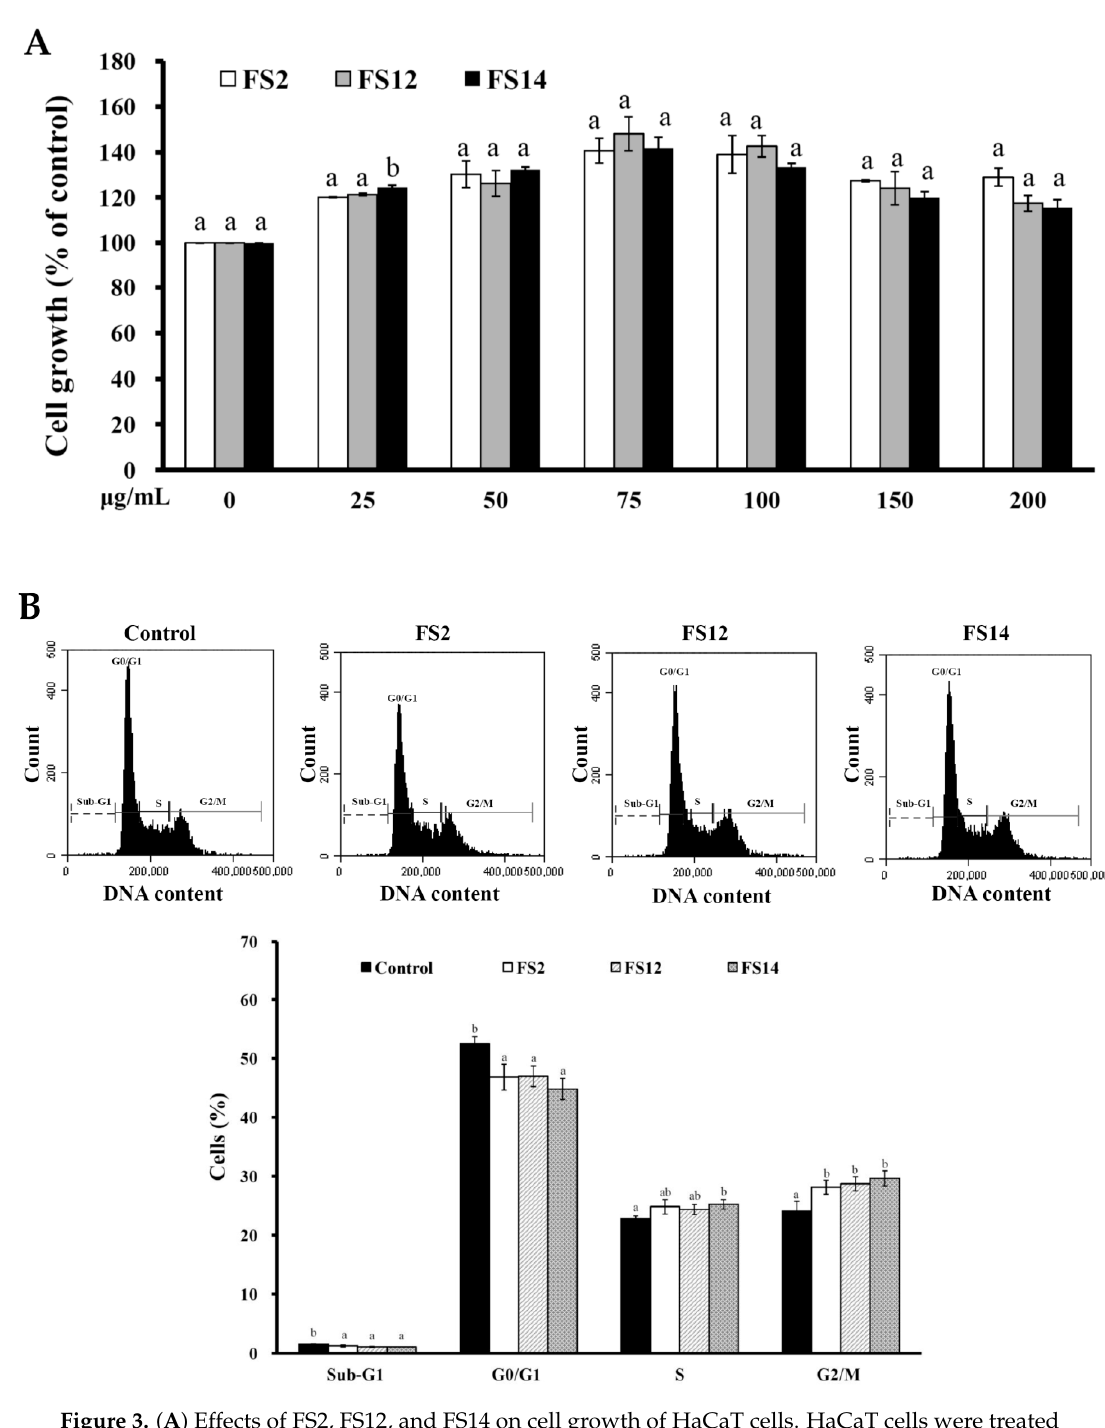
Figure 3. ( A ) Effects of FS2, FS12, and FS14 on cell growth of HaCaT cells. HaCaT cells were treated with different concentrations of FS2, FS12, or FS14, and the cell growth was measured by the MTT assay. The bar graph represents the three experiments and shows the percentage of cell growth for FS2, FS12, and FS14 at different concentrations. ( B ) Effects of FS2, FS12, and FS14 on cell cycle profiles of HaCaT cells. HaCaT cells were treated with FS2, FS12, and FS14 at a concentration of 75 μ g/mL for 24 h, and cell cycle profiles were assessed. Bar graph summarizes three cell cytometric analyses showing the percentages of cells in the sub-G 1 , G 0 /G 1 , S, and G 2 /M phases of the cell cycle according to treatments. The data are represented as means ± SD ( n = 3). In the same treatment or cell cycle stage, different letters (in a and b) upon bars indicate significantly different ( p < 0.05).